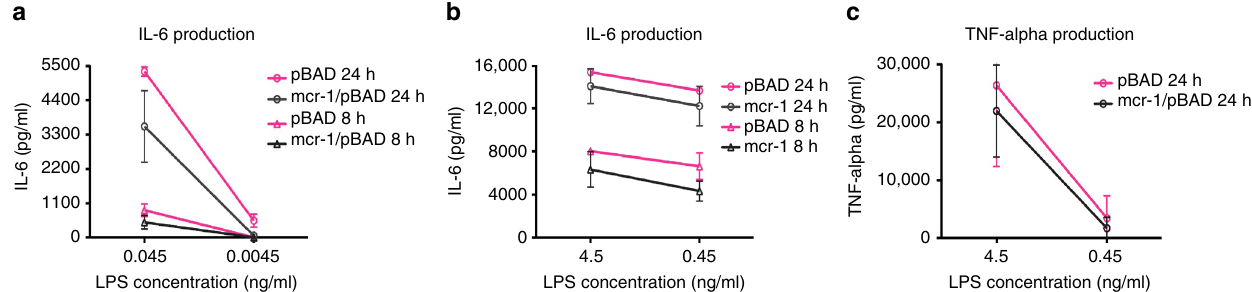
Fig. 7 Expression of cytokines in LPS-mediated THP-1 macrophage. a , b and c indicated IL-6 ( n = 2) and TNF-alpha ( n = 3) productions in the modi fi ed LPS (grey) or normal LPS (red)-treated cell culture, respectively. Error bars represented SD MICs (Supplementary Fig. 7A and Supplementary Table 4). The rate of increase and fi nal level of resistance varied considerably, with PN16 and PN23 reaching 256 mg l − 1 ; PN21, PN25 and PN43 reaching 128 mg l − 1 ; PN42 reaching 32 mg l − 1 , yet PN24 could be increased to 16 mg l − 1 . We also exposed E. coli TOP10 ( mcr-1 /pBAD), E. coli TOP10 (pBAD) and E. coli TOP10 to the same level of passaging (Supplementary Fig. 7B and Supplementary Table 5). E. coli TOP10 ( mcr-1 /pBAD) (in the absence of arabinose) displayed a − 1 ) increase in colistin MICs. However, 64-fold (from 0.5 to 32 mg l both E. coli TOP10 (pBAD) and E. coli TOP10 did not show any − 1 ± 1 dilution over elevation in colistin MICs remaining at 0.125 mg l the 14-day challenge. These data indicate that the increase in colistin resistance shown by E. coli TOP10 ( mcr-1 /pBAD) is singularly due to the presence of mcr-1 . Both the expression level and copy number NATURE COMMUNICATIONS | 8: 2054 | DOI: 10.1038/s41467-017-02149-0 |